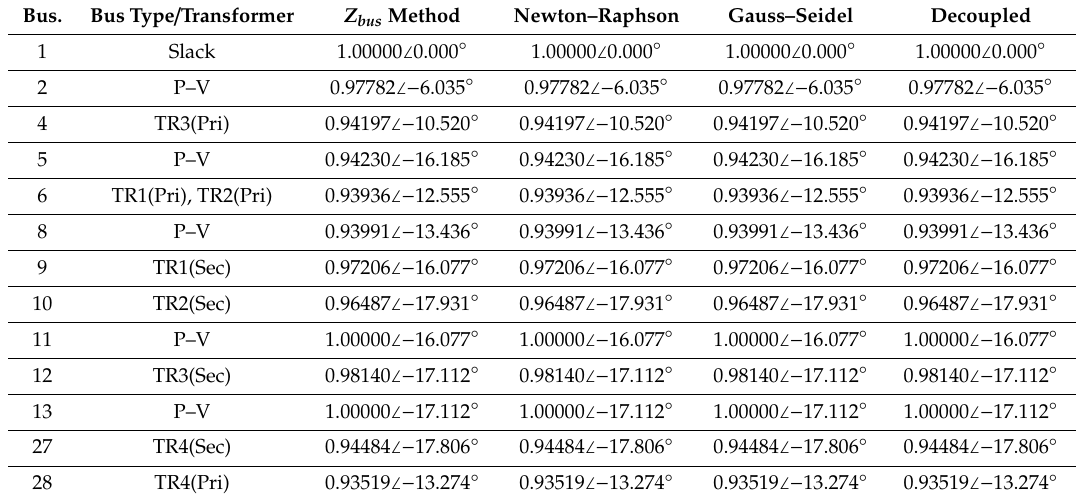
Table A2. Voltage profile of the IEEE 30-bus system (in